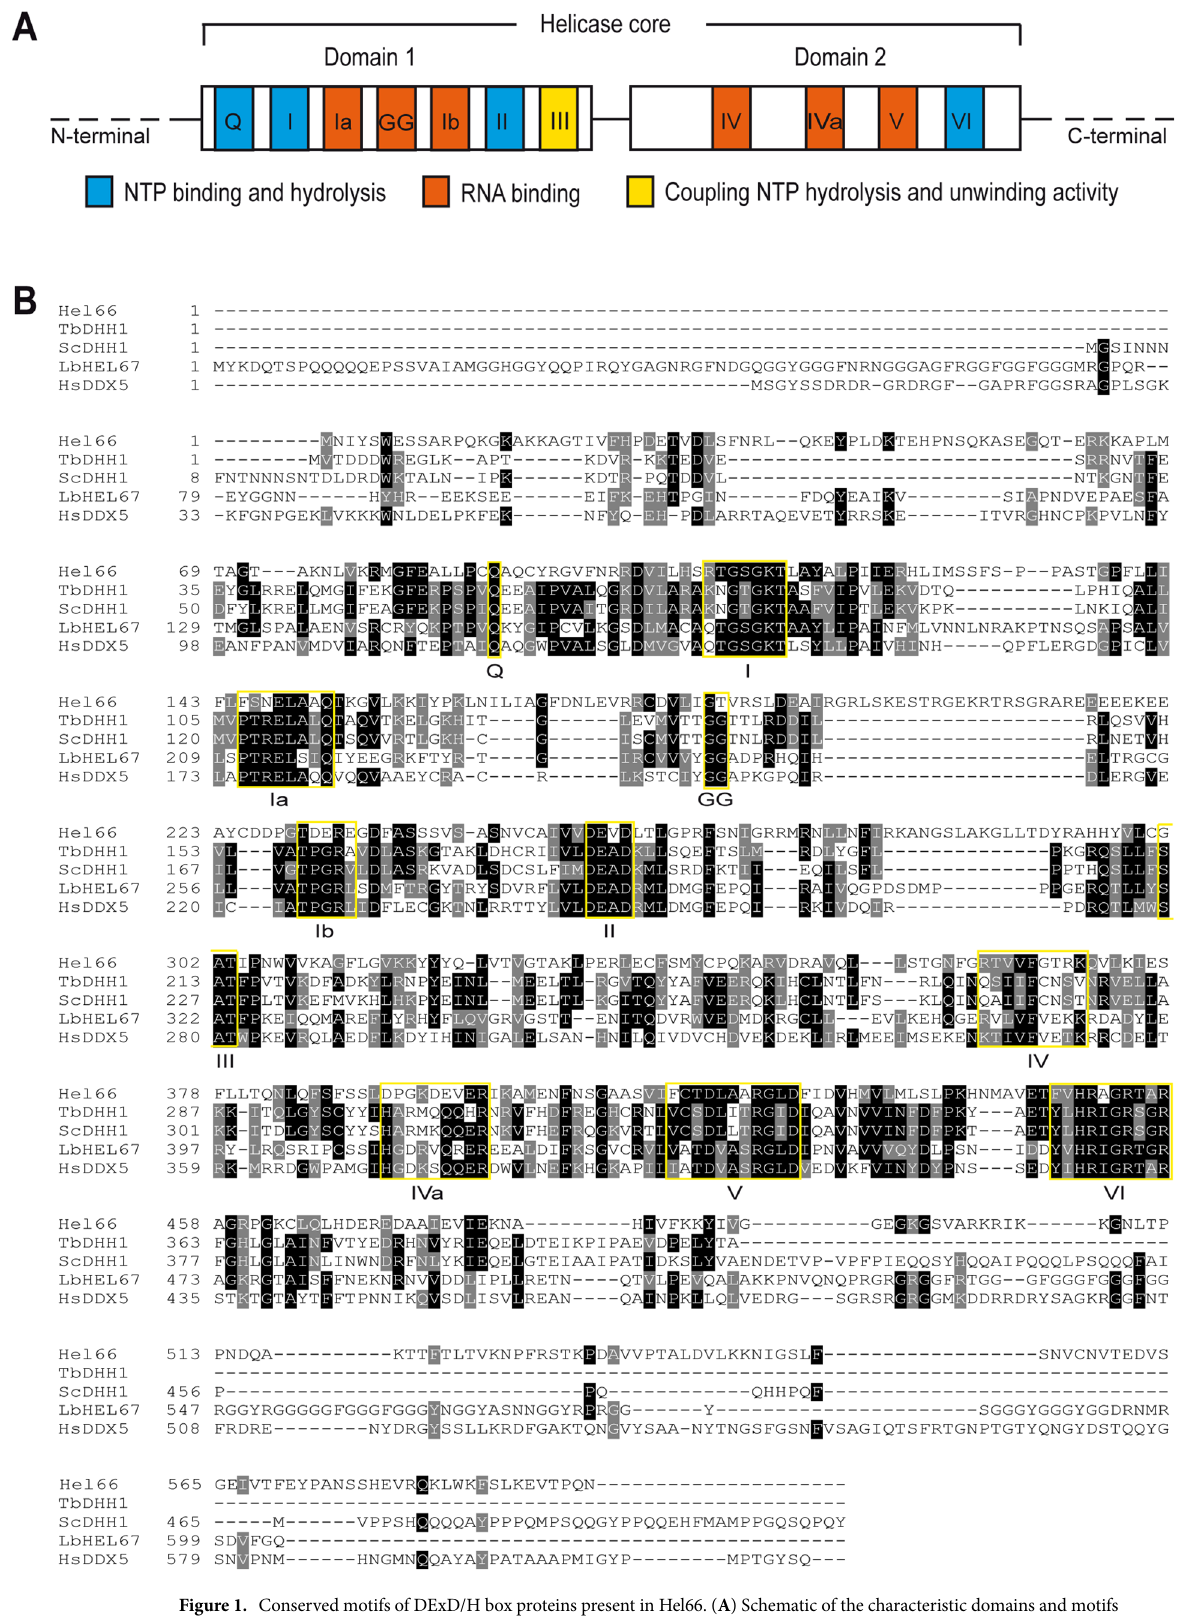
Figure 1. Conserved motifs of DExD/H box proteins present in Hel66. ( A ) Schematic of the characteristic domains and motifs of DExD/H box proteins. ( B ) Alignment of Hel66 to previously characterised DEAD box helicase proteins of Trypanosoma brucei (TbDHH1), Saccharomyces cerevisiae (ScDHH1), Leishmania braziliensis (LbHEL67) and Homo sapiens (HsDDX5). The characteristic motifs of the DExD/H family are shown in yellow boxes. Black and grey shading indicates identical and similar residues, respectively. The alignment was carried out using Clustal Omega (https:// www. ebi. ac. uk/ Tools/ msa/clustalo/) and formatted for visualisation using BoxShade (https:// embnet. vital- it. ch/ softw are/ BOX_ form.